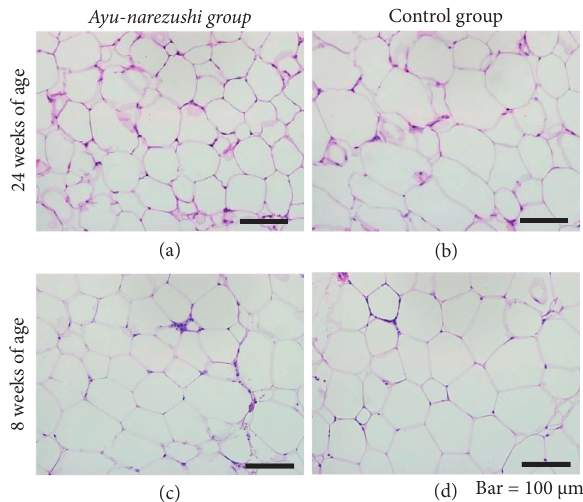
Figure 2: Micrographs of visceral fat in the Tsumura Suzuki obese diabetes (TSOD) mice that were fed the ayu-narezushi (a, c) or control (b, d) chow. The samples are from mice at 8 and 24 weeks of age. The size of the visceral adipocytes in the ayu-narezushi group (a) is remarkably smaller than that of the control group (b) at 24 weeks of age, although they are comparable between the two groups (c, d) at 8 weeks of age ( × 200 magnification). Bar � 100 μ